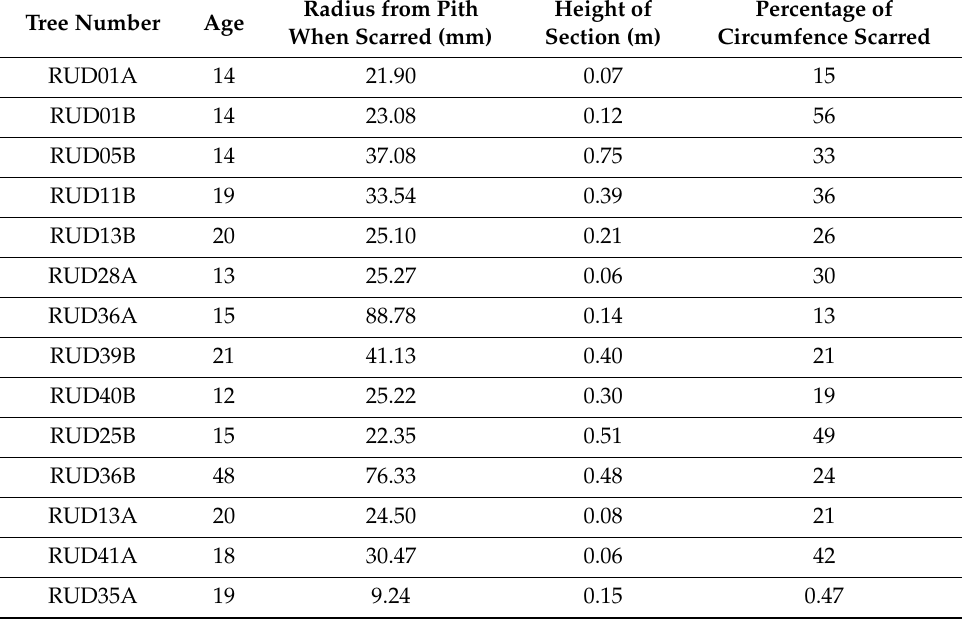
Table 1. Age, radius from pith (mm), and height about the bole from ground surface (m), along with percentage of the circumference scarred for each of the 14 trees used in this study. Radius from Pith Height of Percentage Tree Number Age When Scarred (mm) Section (m)